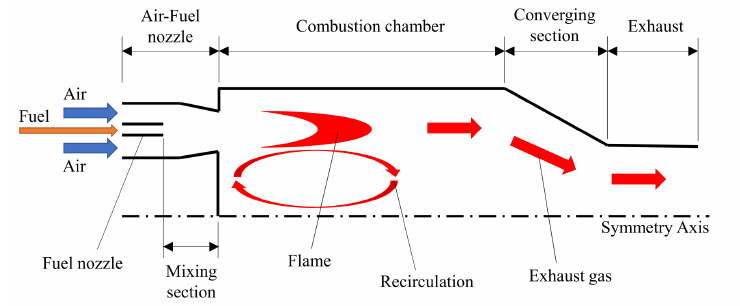
Figure 2. Schematic of the FLOX ® burner